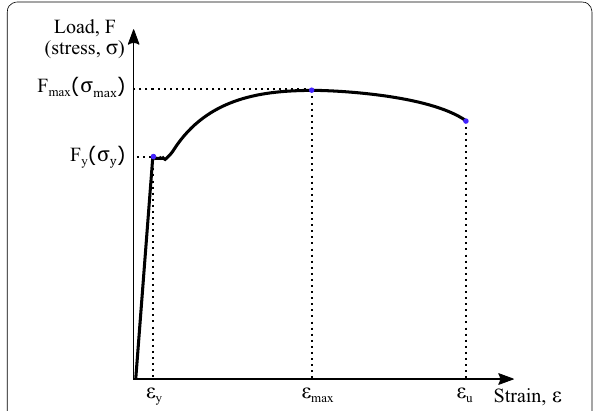
Fig. 7 Description of the most relevant parameters of the mechanical properties.